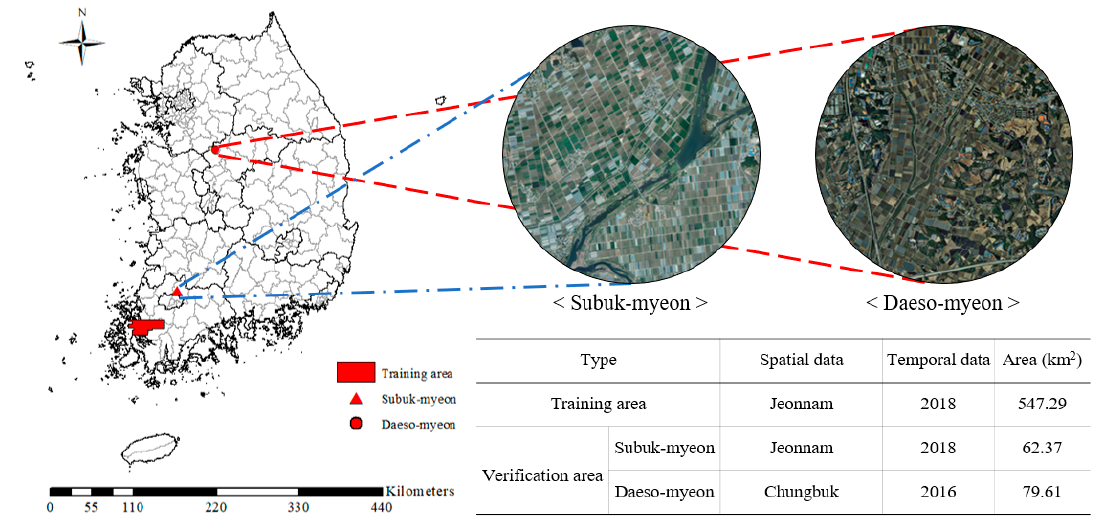
Figure 5. Study areas for the model training and verification.